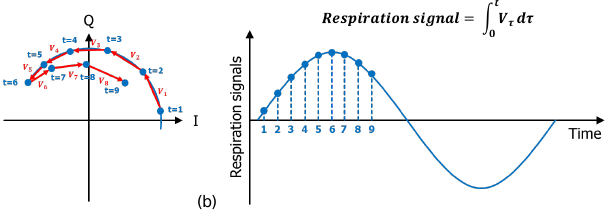
Figure 4. The mechanism for demodulating respiratory signals from radar output signals: ( a ) respiratory signals in the complex domain and ( b ) demodulated respiratory